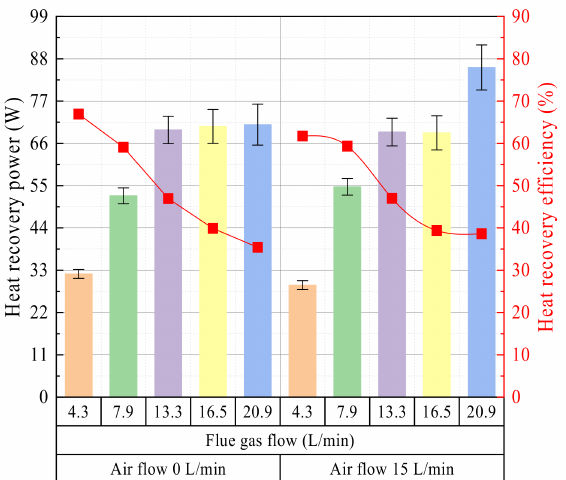
Figure 12. Heat recovery power/efficiency vs. flue gas flow. Experiment conditions: flue gas inlet temperature 56.36 ◦ C, negative pressure airflow 15 L/min, negative pressure air inlet temperature 14.08 ◦ C, membrane pore size 10